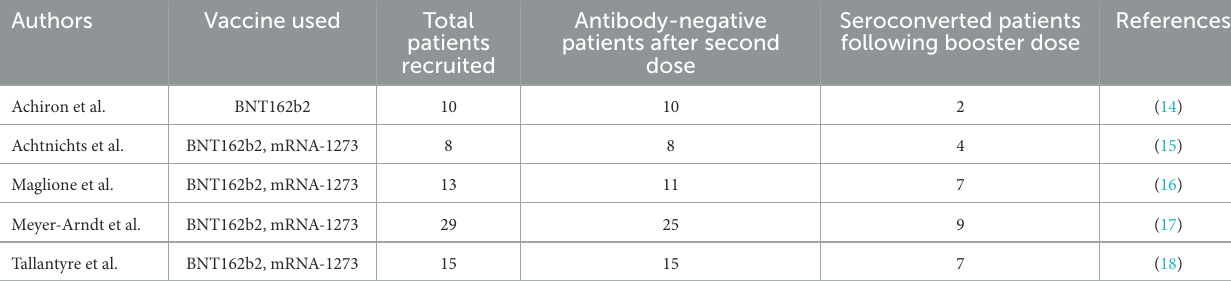
TABLE 2 Comparison between different studies reporting seroconversion of fingolimod-treated MS patients following SARS-CoV-2 booster dose.